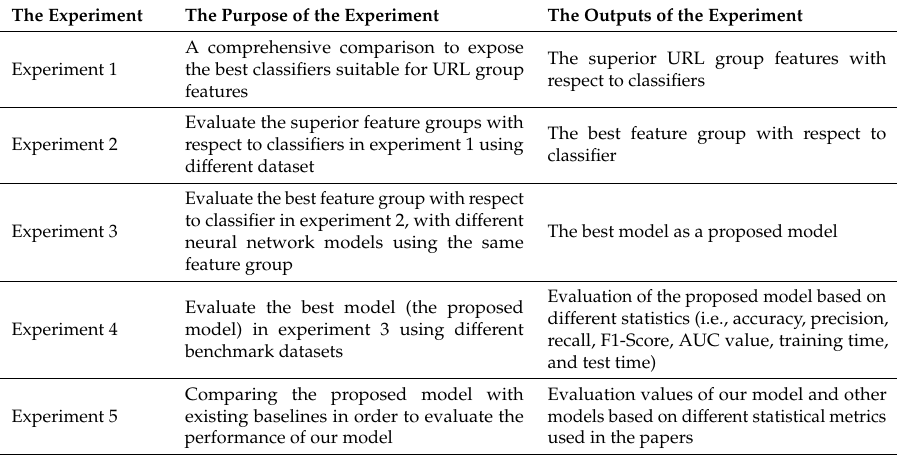
Table 4. Summary of the five